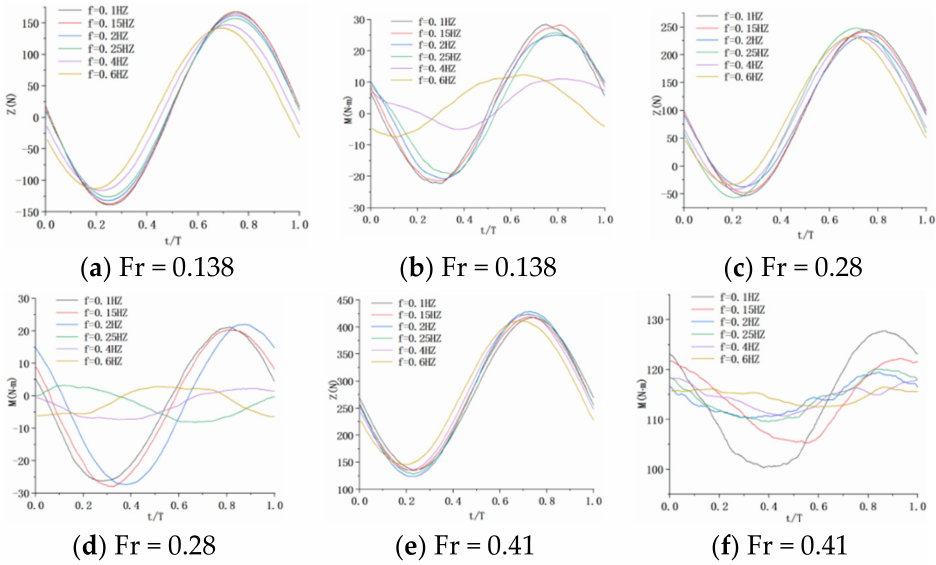
Figure 8. The time-history curves of the vertical force and pitch